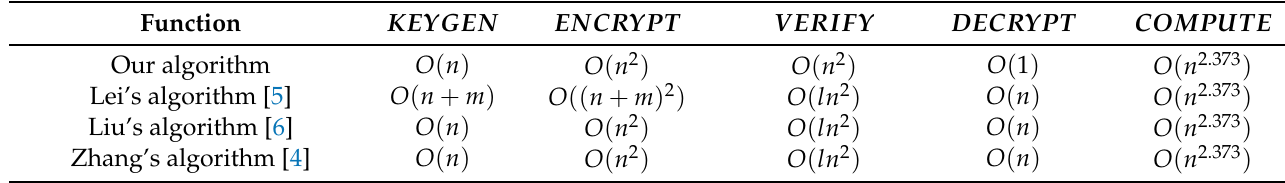
Table 5. Theoretical computational